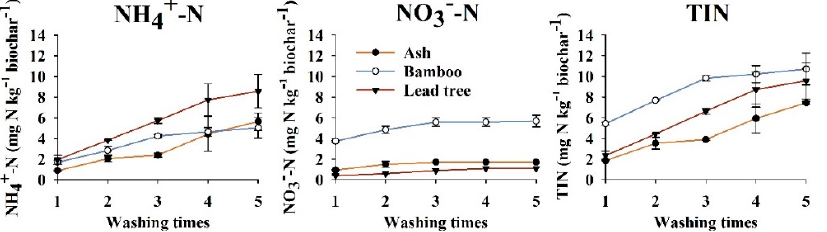
Figure 1. The concentrations of cumulative ammonium (NH 4+ -N), nitrate (NO (cid:2871)(cid:2879) -N), and total inor- ganic nitrogen (NH 4+ -N + NO (cid:2871)(cid:2879) -N) extracted with water from ash, bamboo, and lead tree biochar over 5 repetitions. Error bars represent the standard deviation of the mean ( n = 3).